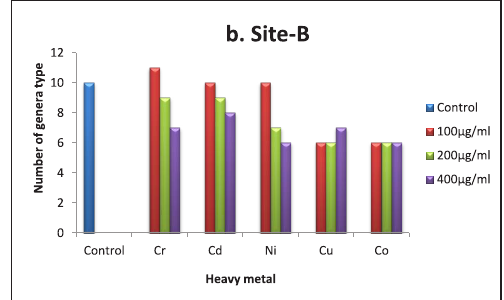
Fig. 2b. Diversity of soil fungal genera at different concentration of heavy metals from site-B.